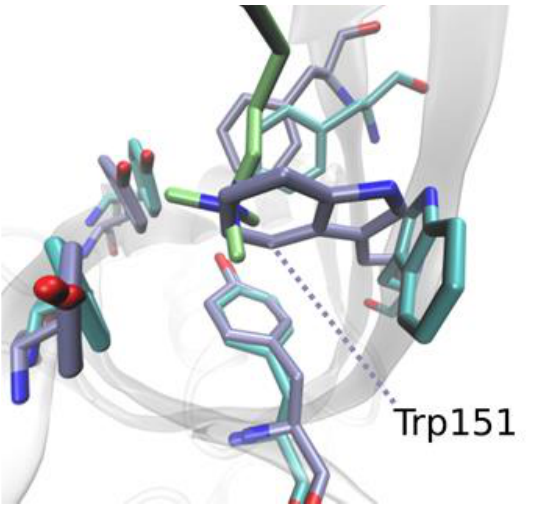
Figure 5. Molecular dynamics simulations reveal flip of Trp151 in the K4me3 aromatic cage.